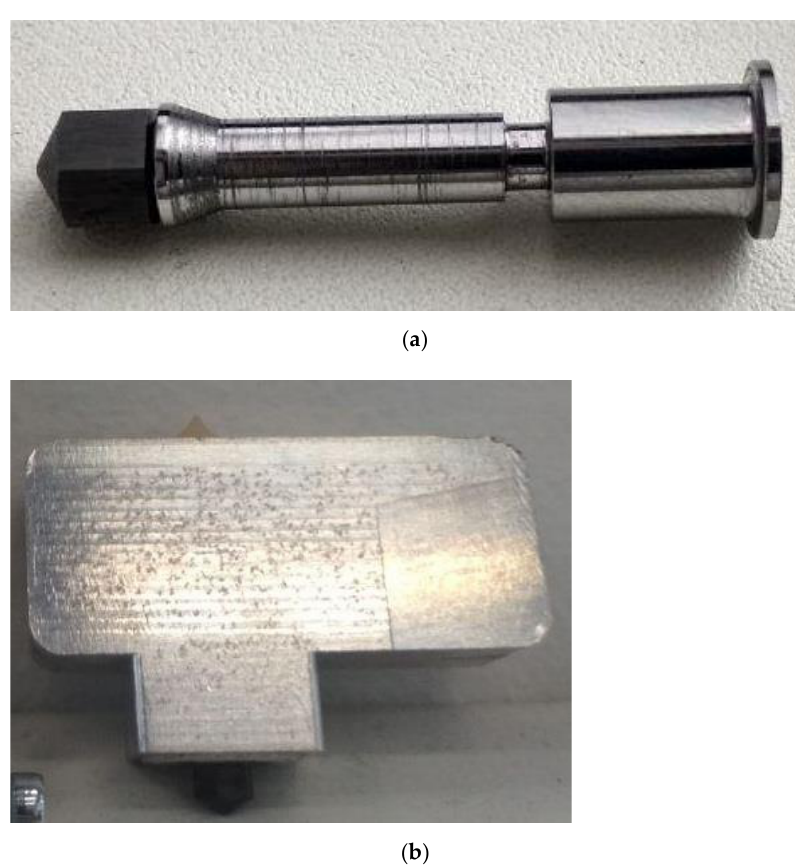
Figure 1. ( a ) Appearance of the ferromagnetic nozzle, ( b ) appearance of the pilot extruder.